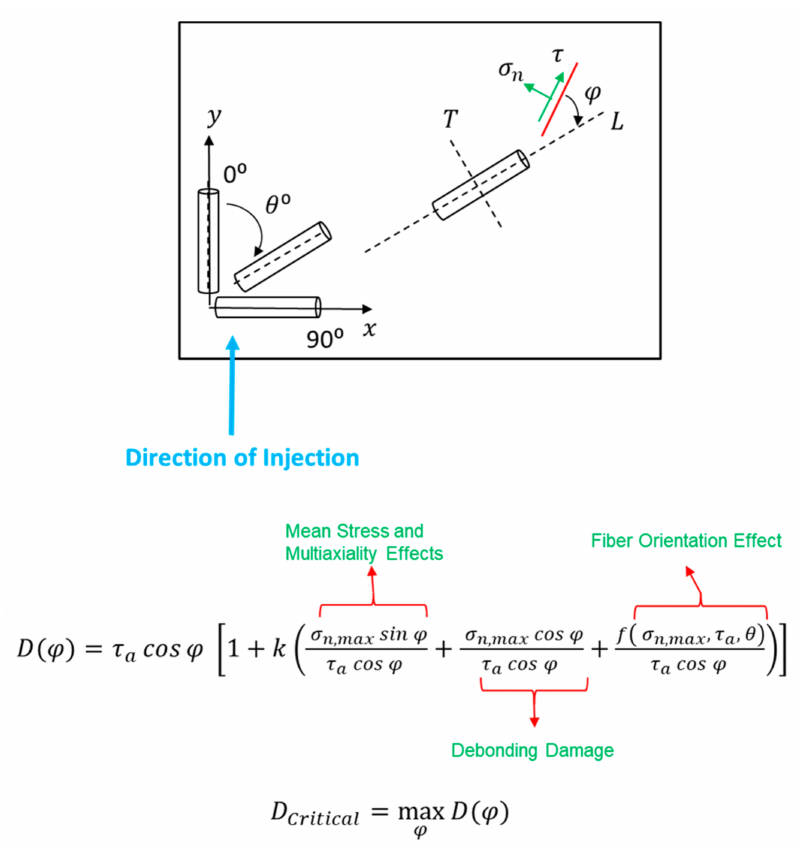
Figure 3. Proposed critical plane damage parameter for fatigue life prediction of oriented reinforced glass fiber thermoplastic composites.